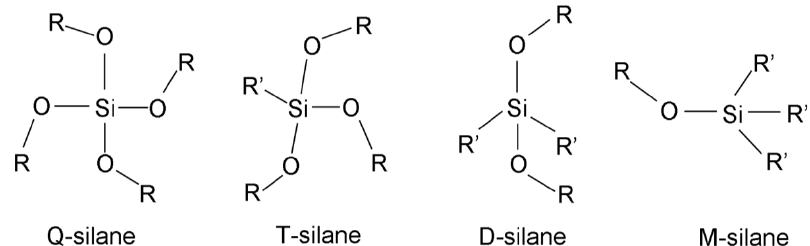
Figure 1. Scheme showing the different types of reacted silanes, where R is an alkyl and R’ is any organic